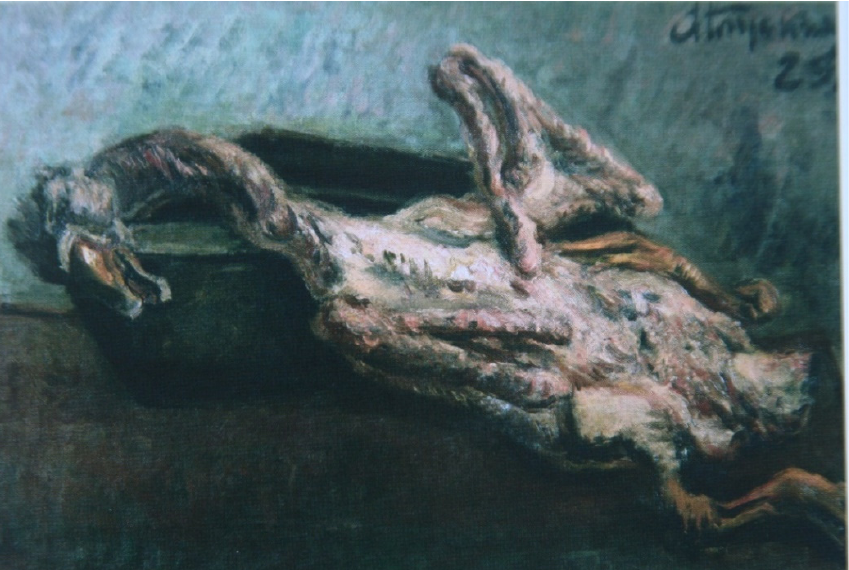
Figure 1. A. Gluskin. The Tragedy of the Goose .